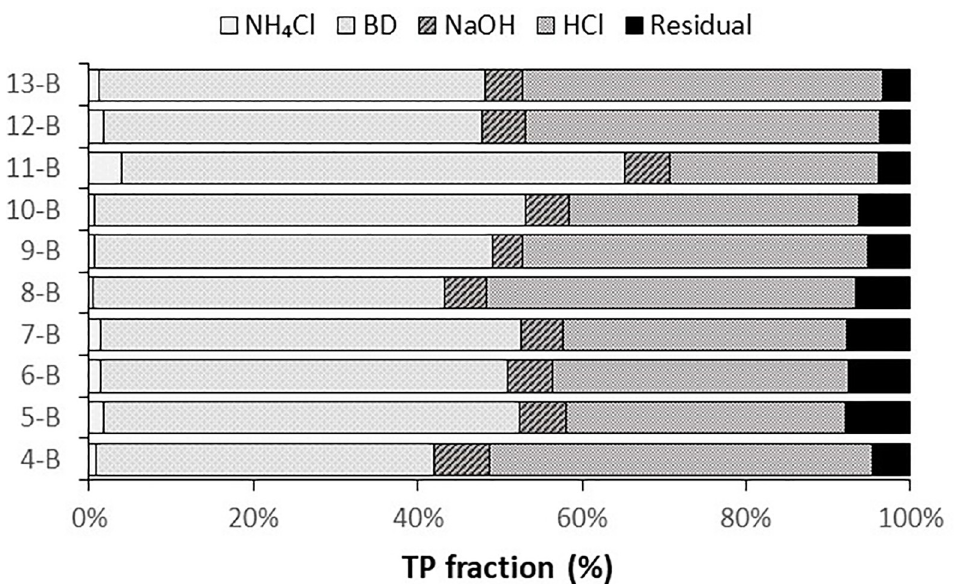
Fig 4. Sediment sequential extraction results. Extraction results for 10 sediment samples collected during May—June 2016. Results are expressed as % total phosphorus NH 4 Cl = P in pore water and adsorbed loosely to surfaces, BD = redox-sensitive P mainly bound to oxidized Fe and Mn compounds, NaOH = P exchangeable against OH- ions or bound in organic matter, HCl = calcium phosphate minerals, and the residual is refractory organic P and nonextractable mineral